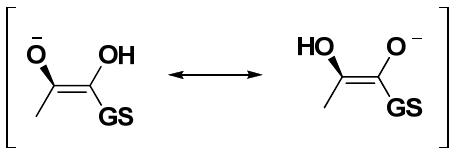
Figure 1. Transition state inside the active site of Glo1.